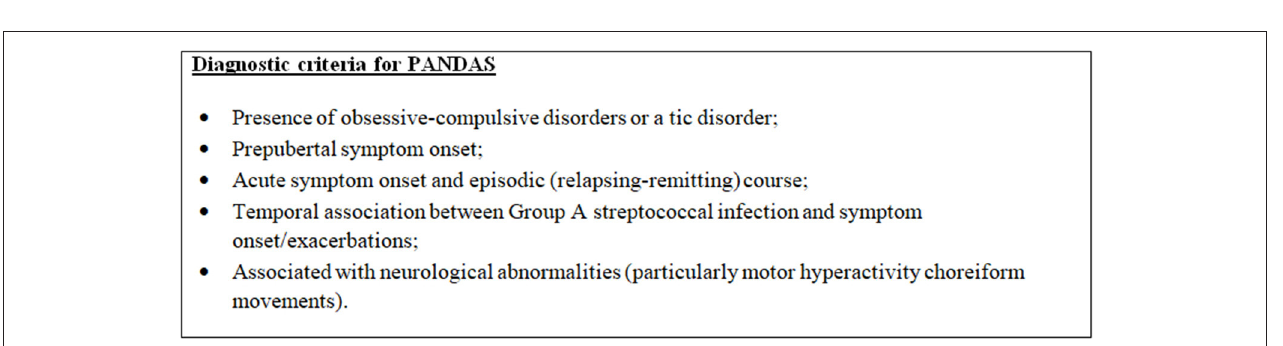
FIGURE 2 | Diagnostic criteria for Autoimmune Neuropsychiatric Disorder Associated with Streptococcal Infections (PANDAS), modified from 2013 PANS Consensus Conference ( 2,